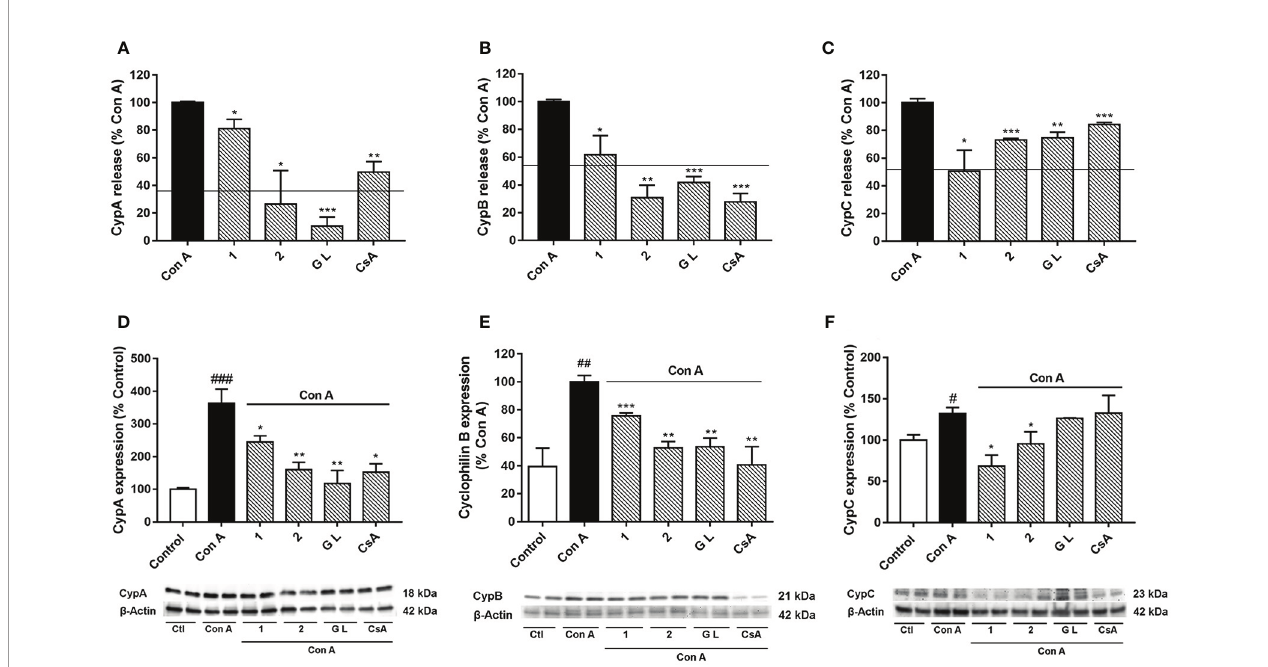
FIGURE 3 | Effect of compounds 1 , 2 , and GraL over intra and extracellular CypA, B and C levels in human T lymphocytes stimulated with Con A Cells were pre- treated with compound 1 , 2 (0.1 µM), GraL (1 m M) or CsA (0.2 µM) for 2 h and then were stimulated with Con A (50 m g/mL) for 48 h. CypA (A) , CypB (B) , and CypC (C) levels were measured by ELISA in the medium of T lymphocytes. The line represents the unstimulated cells values. The intracellular expression of CypA (D) , CypB (E) , and CypC (F) was measured by western blot in cytosolic lysates of T lymphocytes. Band intensity was normalized by b -actin. Data are the result of average ± SEM (n = 3). The values are shown as the difference between cells treated with Con A and cells treated with compounds plus Con A, * p < 0.05, ** p < 0.01 and *** p < 0.001. Values of cells treated with Con A were compared with control cells, # p < 0.05, ## p < 0.01 and ### p < 0.001. One-way ANOVA test with Dunnet ’ s post hoc analysis and Student´s t-test were used for statistical